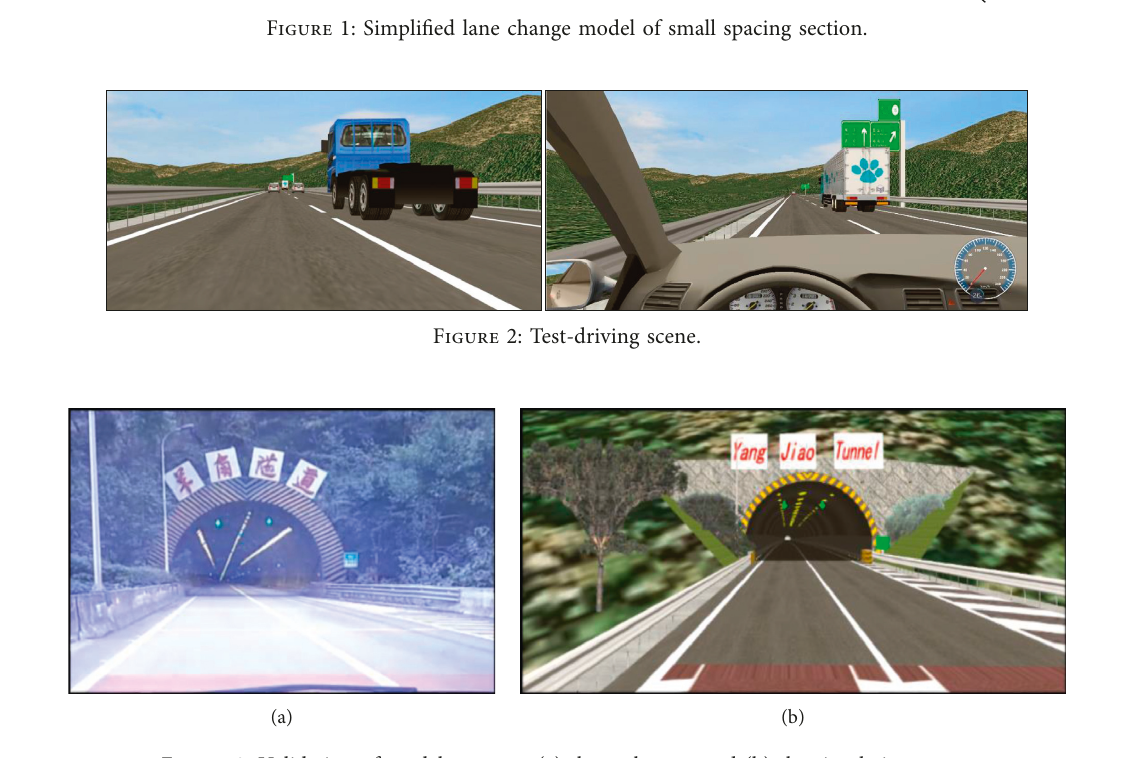
Figure 3: Validation of model accuracy (a) the real scene and (b) the simulation